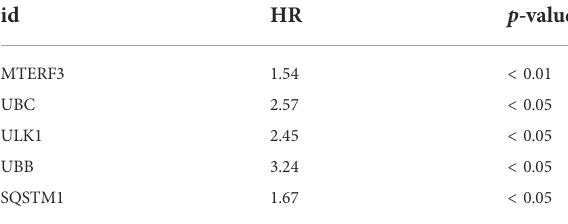
TABLE 3 Univariate COX analysis of GEO data